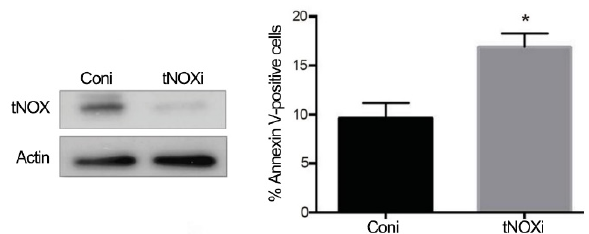
Figure 6. tNOX depletion enhances spontaneous apoptosis in Hep3B cells. tNOX was knocked down by RNA interference in p53-deficient Hep3B cells for 24 h, and the percentage of apoptotic cells was determined by flow cytometry. The presented values (mean ± SEs) represent at least three independent experiments (* p < 0.05 for tNOX-knockdown cells vs. controls). Representative images